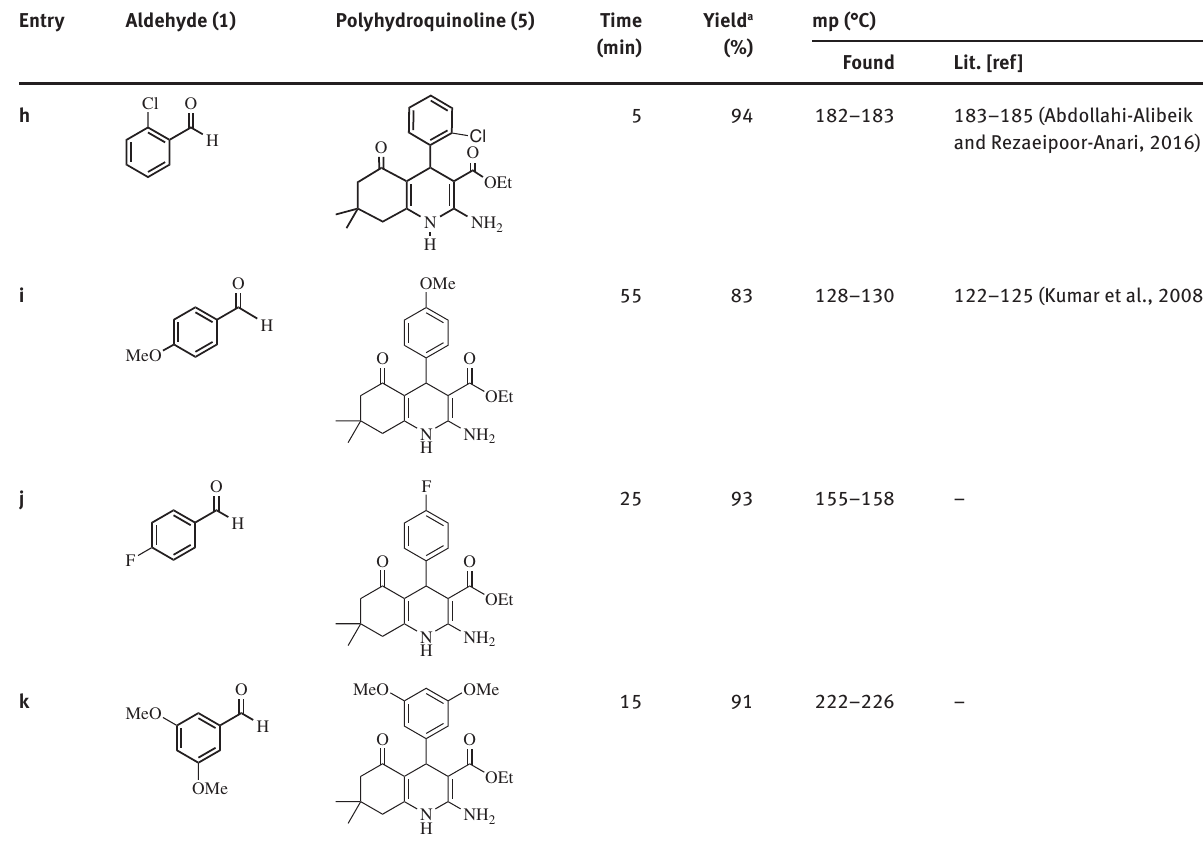
Table 4: Recycling of FSM-16-SO